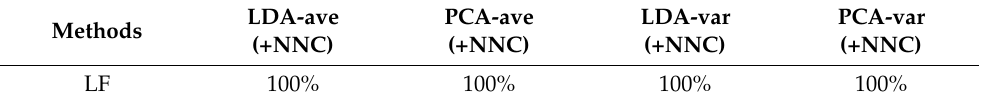
Figure 13. Grade classification results for West Lake Longjing tea identified using LF. Table 10. Discrimination accuracy of West Lake Longjing tea grades by